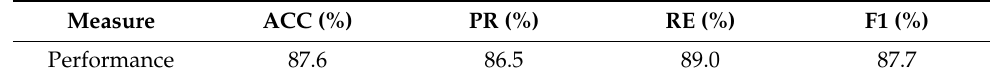
Table 5. Performance of DRU-DNN with MFE.